Question: State the chart type depicted above.
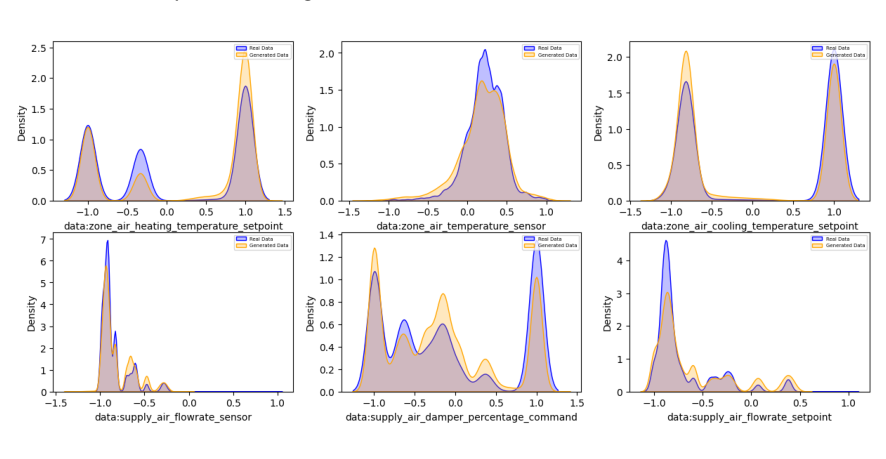
Answer: line